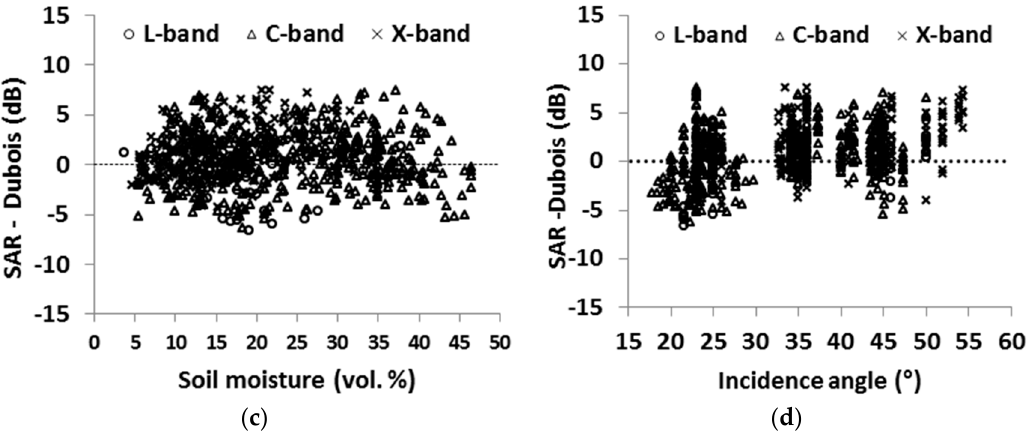
Figure 2. Comparison between backscattering coefficient values obtained from SAR images and those estimated using the Dubois model at VV polarization. ( a ) Dubois model simulations vs. SAR data; ( b ) difference between SAR signal and Dubois model vs. soil roughness ( kHrms ); ( c ) difference between SAR signal and the Dubois model vs. soil moisture ( mv ); ( d ) difference between SAR signal and the Dubois model vs. incidence angle. Table 2. Comparison between the Dubois model output and real data using the entire dataset, and by separating two intervals of kHrms , soil moisture ( mv ) and incidence angle ( θ ). Bias = real data − simulations.